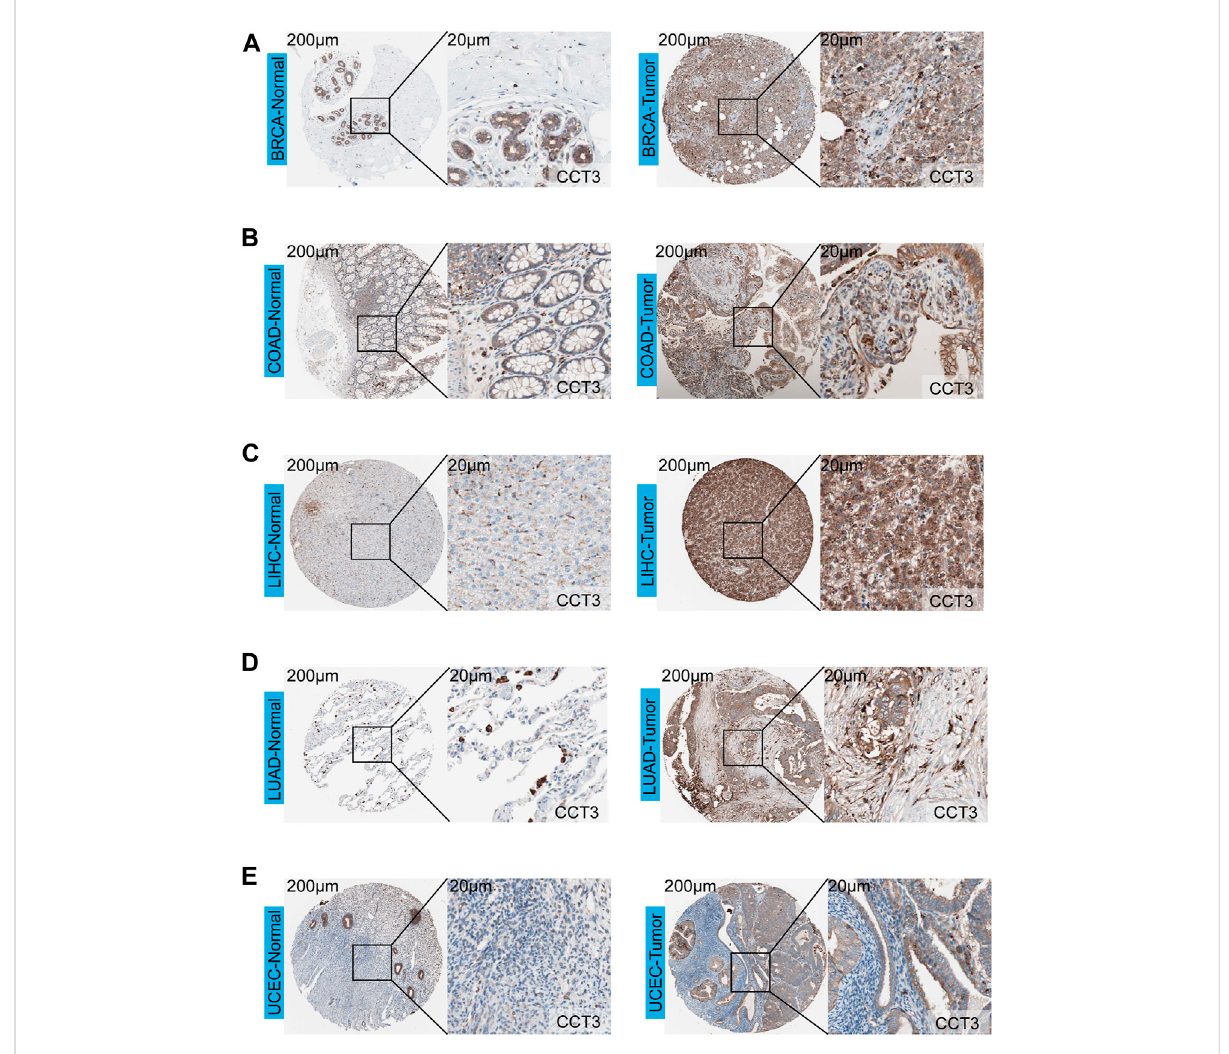
ImmunohistochemistryanalysisofCCT3protein.TheproteinlevelsofCCT3wereanalyzedbyIHCinseveralcancertypes: (A) BRCA, (B) COAD, (C) LIHC, (D) LUAD, (E)